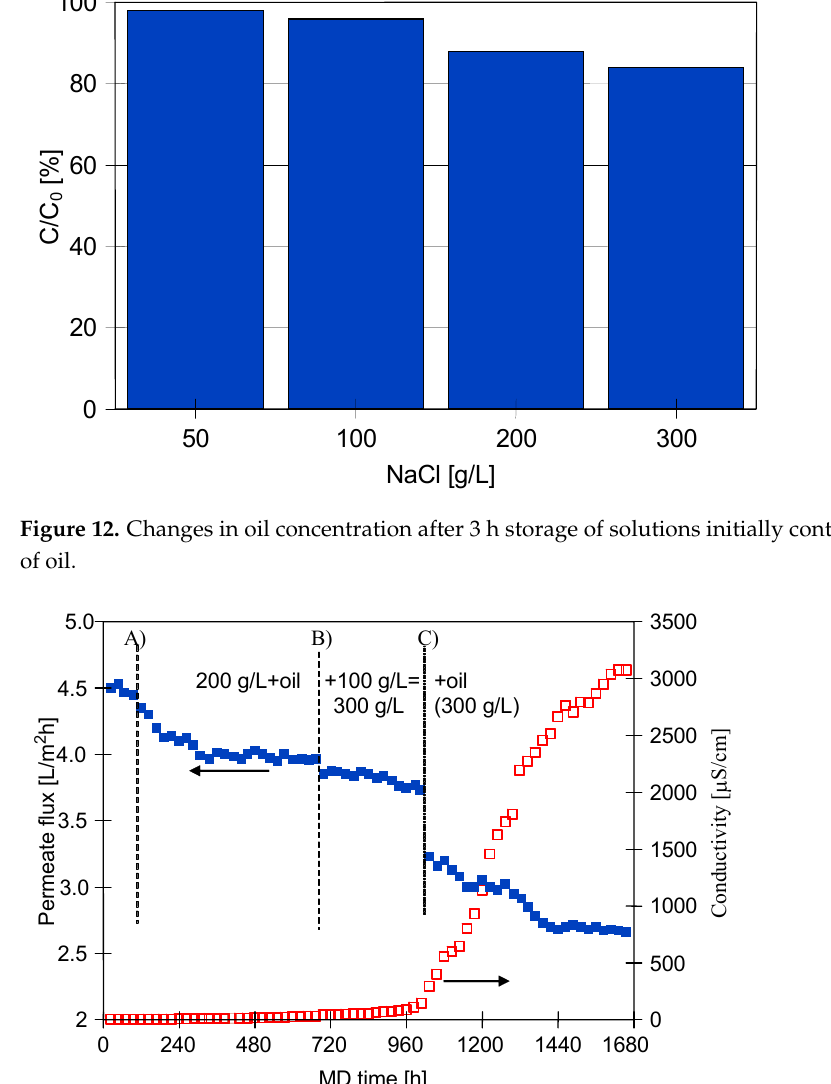
Figure 13. Changes in the permeate flux and distillate conductivity for various feed solutions. Initial feed: NaCl solution (200 g/L). Added to the feed: (A) oil 108 mg/L, (B) 100 g/L NaCl and (C) oil 112 mg/L. Module: SMD ‐ S6 ‐ 3.